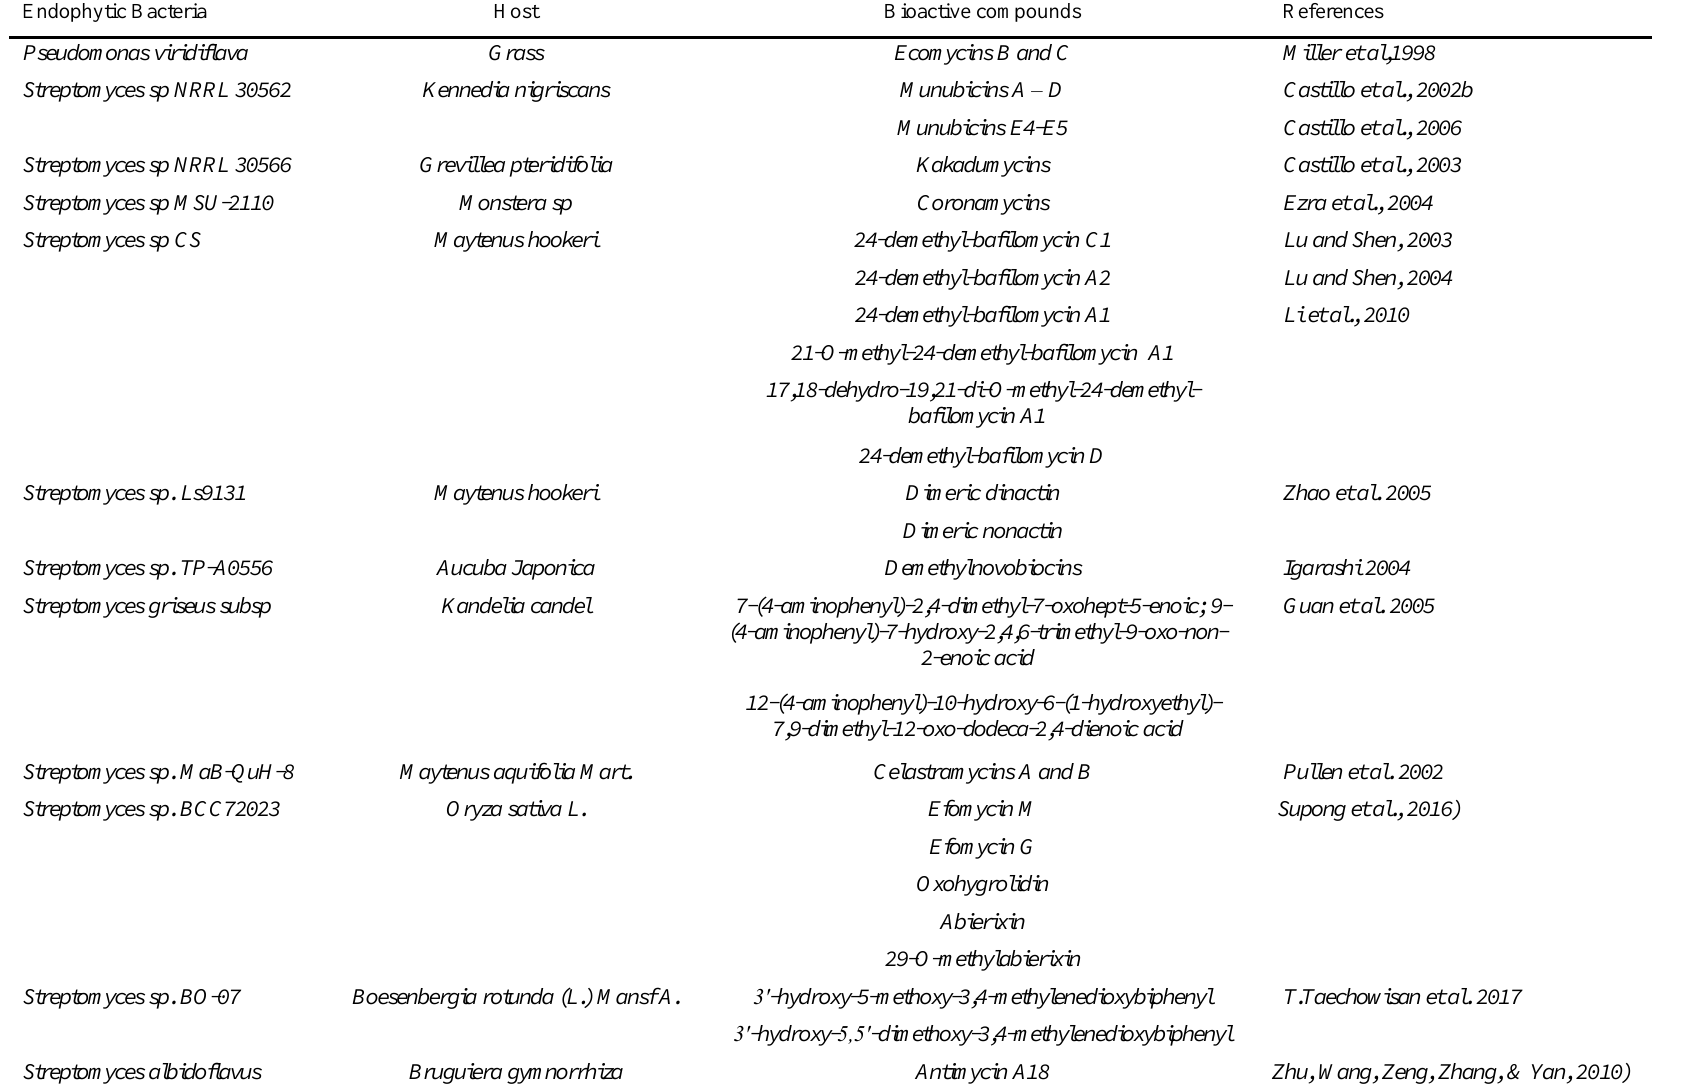
Table 1 : Antimicrobial Compounds Produced by Various Endophytes and Its Host